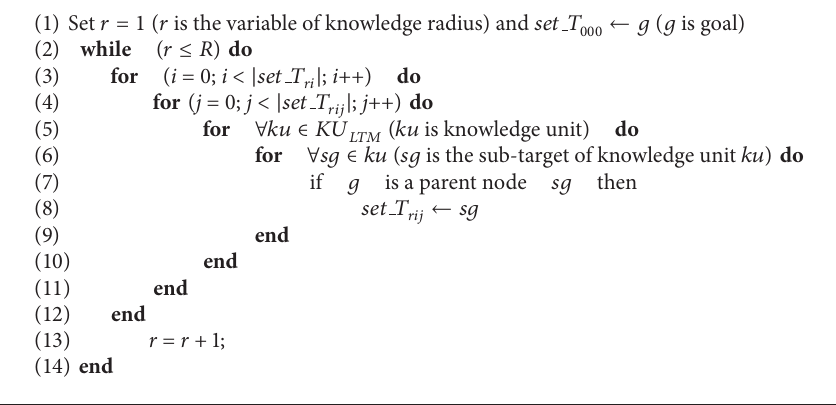
Algorithm 2: KST construction